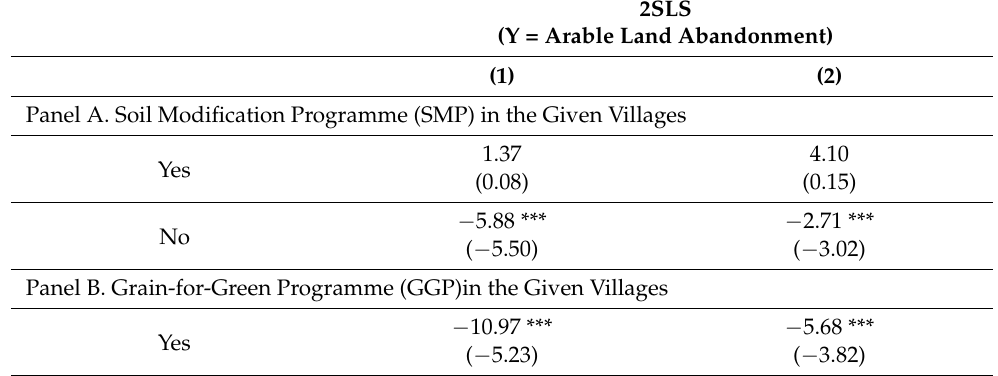
Table 9. The heterogeneity of natural resource endowment. Panel A. Soil Modification Programme (SMP) in the Given Villages Yes No Panel B. Grain-for-Green Programme (GGP)in the Given Villages Yes No Panel C. Closing-Hillsides-for-Afforestation Programme (CHAP) in the Given Villages Yes No Panel D. Village Terrain Features Plain terrain Hilly terrain Mountainous terrain